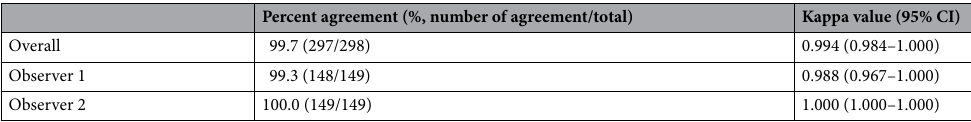
Table 2. Agreement for detecting intracranial lesion between conventional and wave-CAIPI MPRAGE. CI confidence interval, MPRAGE magnetization-prepared rapid gradient echo, wave-CAIPI wave-controlled aliasing in parallel imaging.